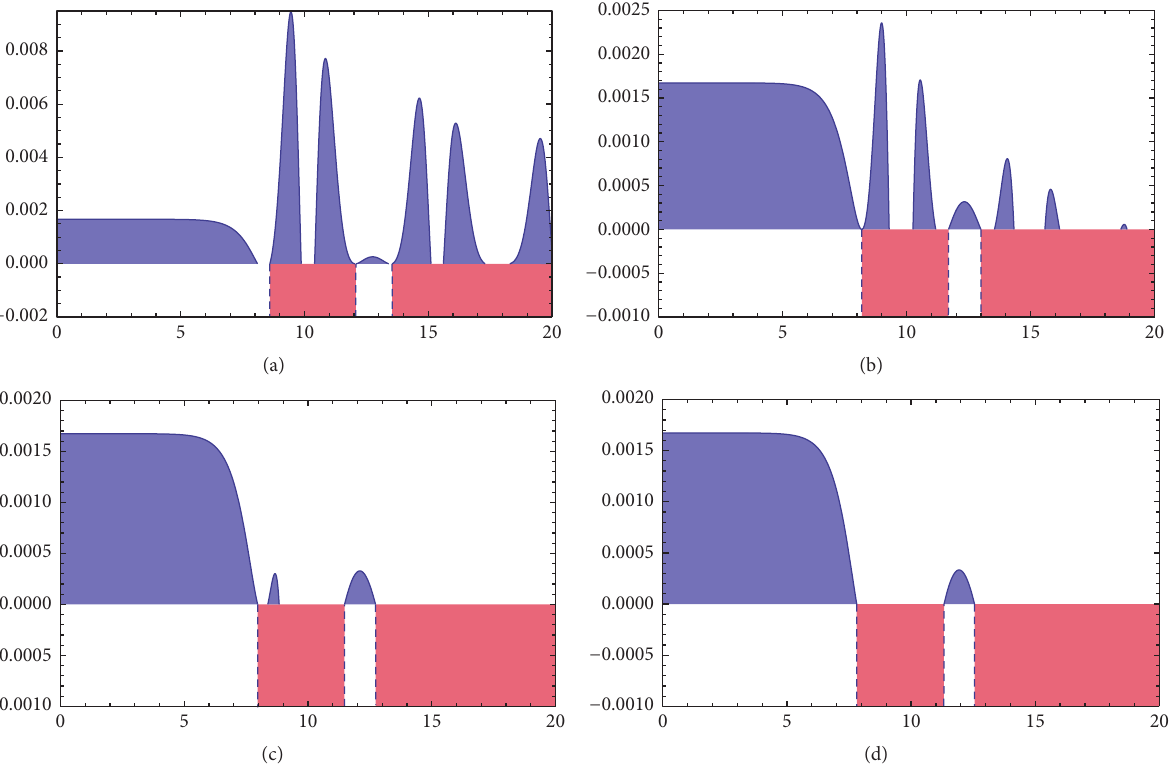
Figure 9: The Jacobi stability regions for the scalar field cosmological model with Higgs potential for different values of 𝜂 : 𝜂 = 10 (a), 𝜂 = 20 (b), 𝜂 = 30 (c), and 𝜂 = 40 (d). The blue area shows the time intervals with 𝜒 > 0 , and the black area shows the time intervals with 𝜅 < 0 . Where they overlap, both conditions 𝜒 > 0 and 𝜅 < 0 are simultaneously satisfied, and the evolution is Jacobi